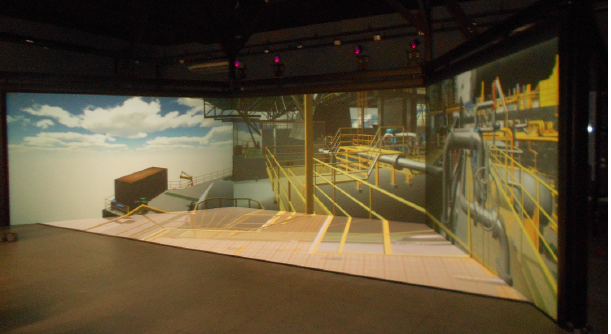
Figure 19. The CAVE used in the